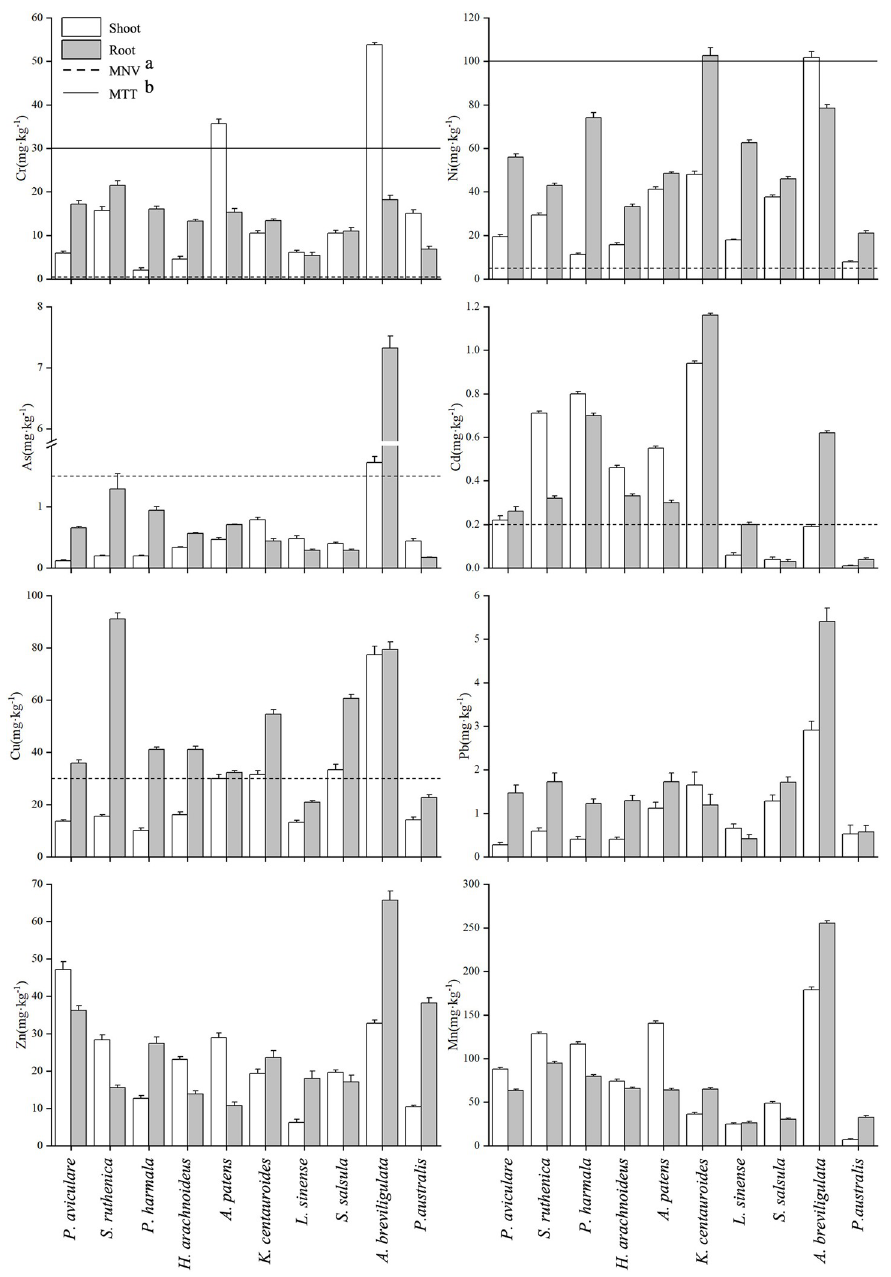
Fig 3. Heavy metal contents in the aboveground and underground parts of 10 native plants (a: MNV, Maximum normal value, b: MTT, Maximum toxicity threshold).